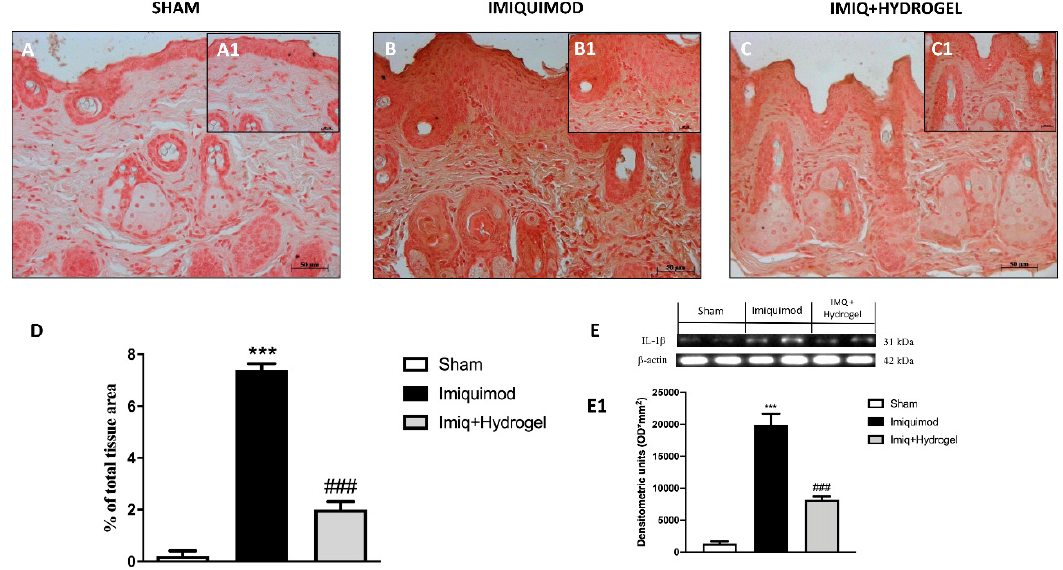
Figure 7. E ff ect of Hydrogel treatment on IL-1 β expression. Immunohistochemical analysis of IL-1 β demonstrated a considerably increased expression in the vehicle group ( B magnification 20 × , B1 magnification 40 × , D , E , E1 ) compared to the control group ( A magnification 20 × , A1 magnification 40 × , D , E , E1 ). Hydrogel treatment reduced the expression of IL-1 β in animals subjected to IMQ damage ( C magnification 20 × , C1 magnification 40 × , D , E , E1 ). Data are representative of at least three independent experiments; One-Way ANOVA test. *** p < 0.001 vs. sham; ### p < 0.001 vs. IMQ.